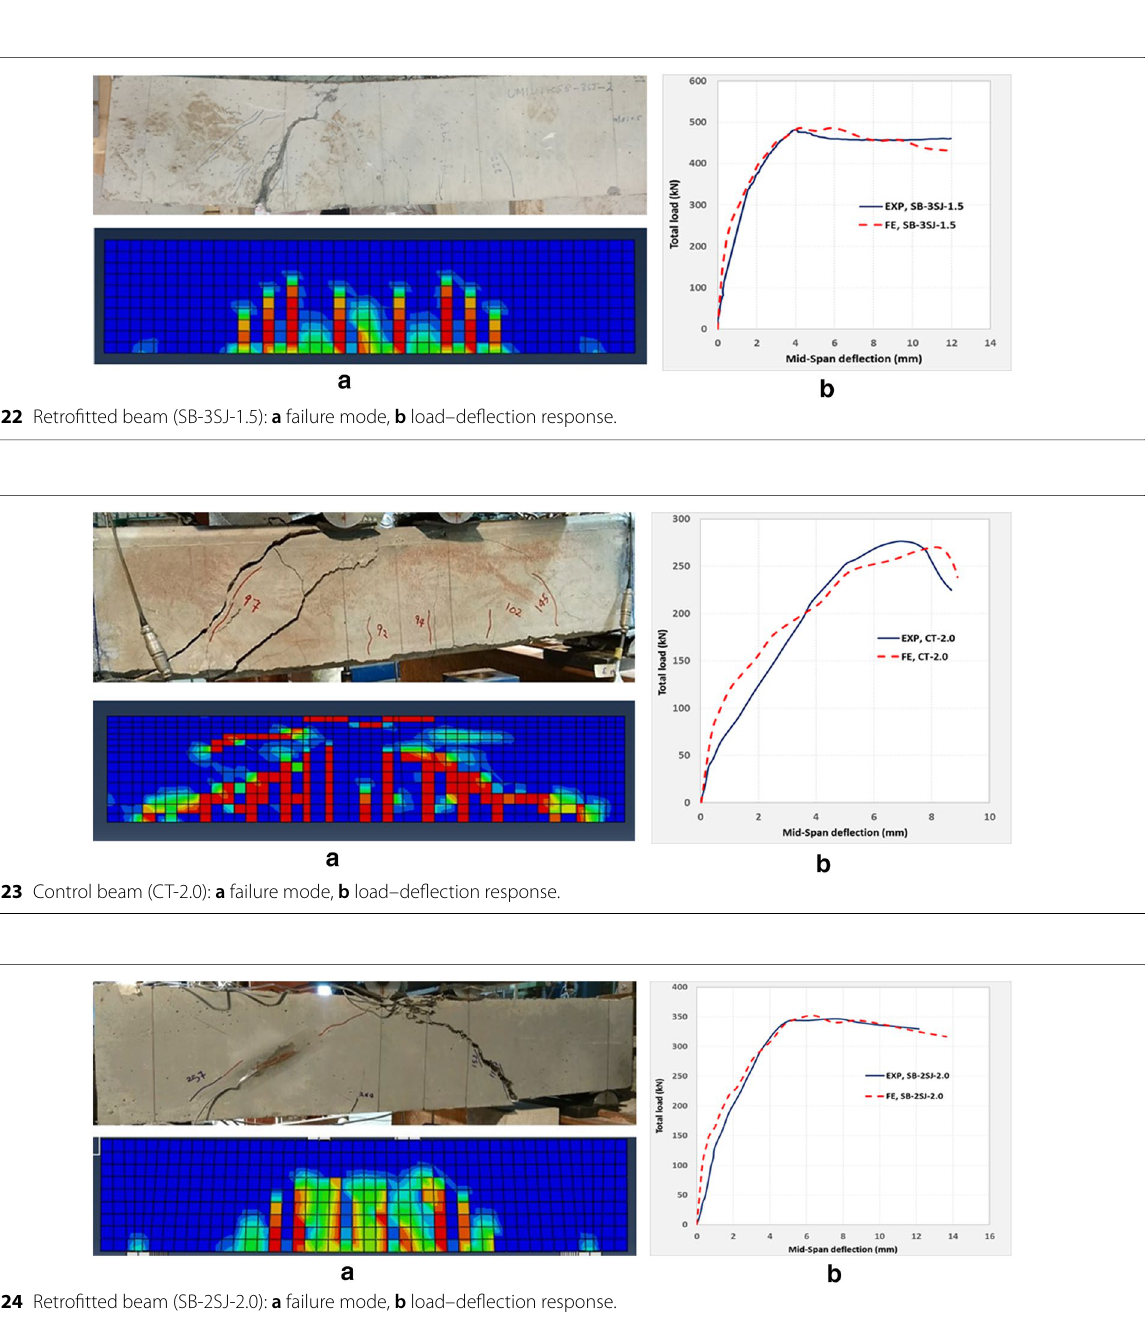
Fig. 24 Retrofitted beam (SB‑2SJ‑2.0): a failure mode, b load–deflection